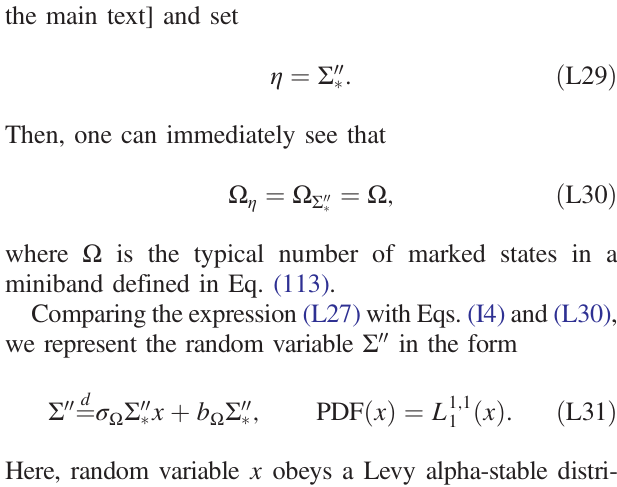
FIG. 20. Probability distribution of the ratio j Y=X j defined in Eqs. (M1) and (M2) for γ ¼ 0 . 6 .